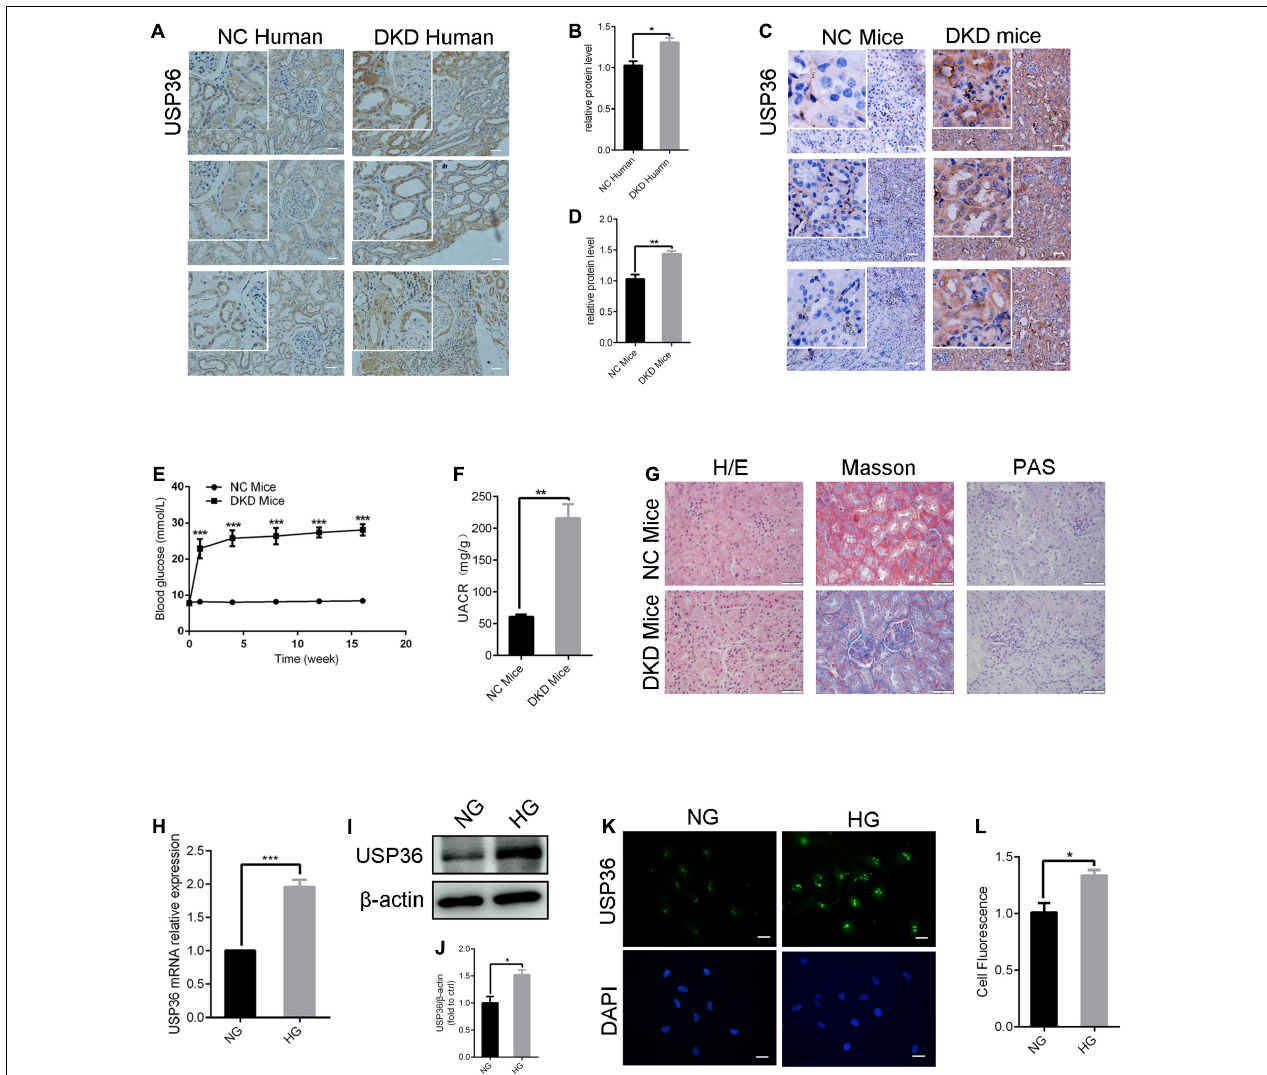
FIGURE 2 | The expression of USP36 is significantly elevated under high glucose conditions in renal TECs both in vivo and in vitro . (A,B) Immunohistochemistry staining for USP36 expression in human kidney sections. NC (normal control) represented the renal histological sections from adjacent normal tissues of patients with renal cell carcinoma. Scale bars = 100 µ m, n = 3. (C,D) Immunohistochemistry staining for USP36 expression in mouse renal tissues. Scale bars = 100 µ m. NC (normal control) represented the renal histological sections from the normal male C57BL/6 mice, n = 3. Scale bars, 100 µ m. (E) The blood glucose level in NC mice and DKD mice, n = 3, *** p < 0.001. (F) Urine albumin to creatine ratio (UACR) in STZ-induced DKD mice, n = 3, ** p < 0.01. (G) Hematoxylin and eosin (H/E) staining, Masson’s trichrome (Masson) staining and Periodic acid-Schiff (PAS) staining in renals from STZ-induced DKD mice. Scale bars = 50 µ m, n = 3. (H,I,K) qRT-PCR, western blotting and immunofluorescent staining were performed to detect the USP36 expression in high glucose induced TECs. Scale bars = 50 µ m. Unpaired, two-tailed t tests were used, n = 3, *** p < 0.001. (J,L) WB and fluorescence analysis of the protein levels of USP36 in high glucose induced TECs. Data are presented as the mean ± S.D, n = 3, * p <